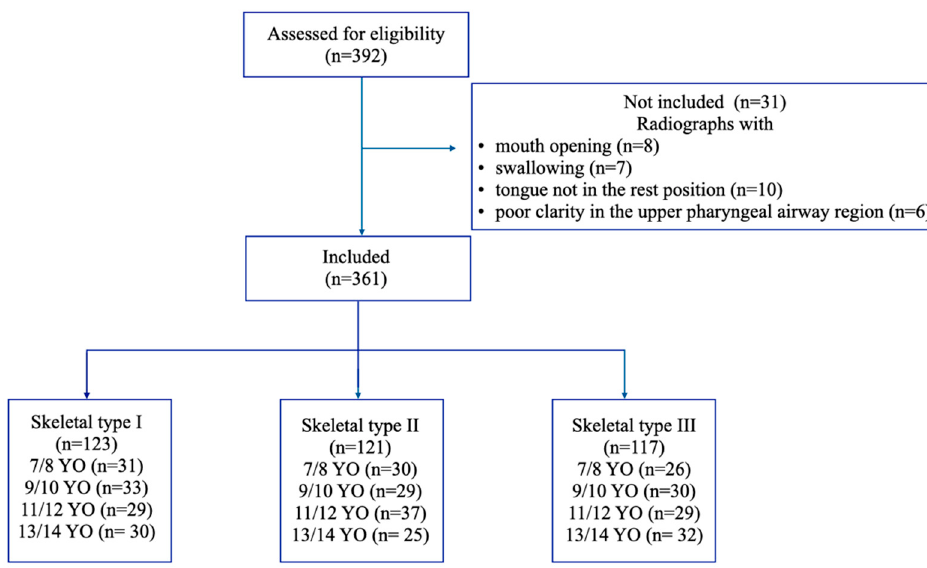
Figure 1. Flowchart of the record selection